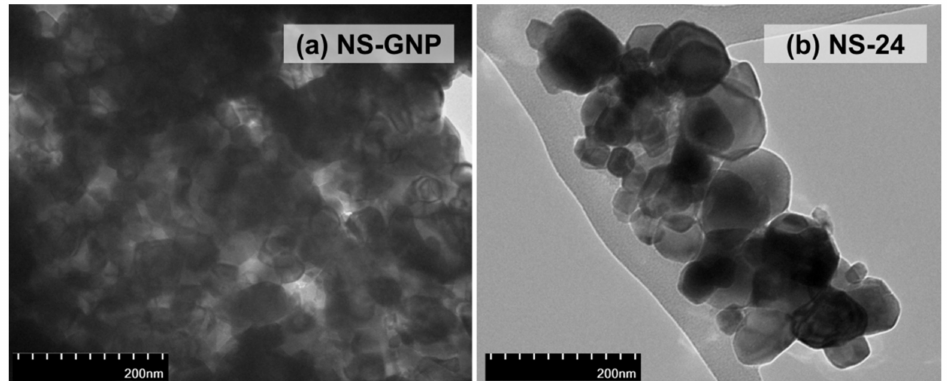
Figure 4. TEM image of NiO–SDC composite anode powders synthesized with different techniques: ( a ) NS-GNP and ( b )